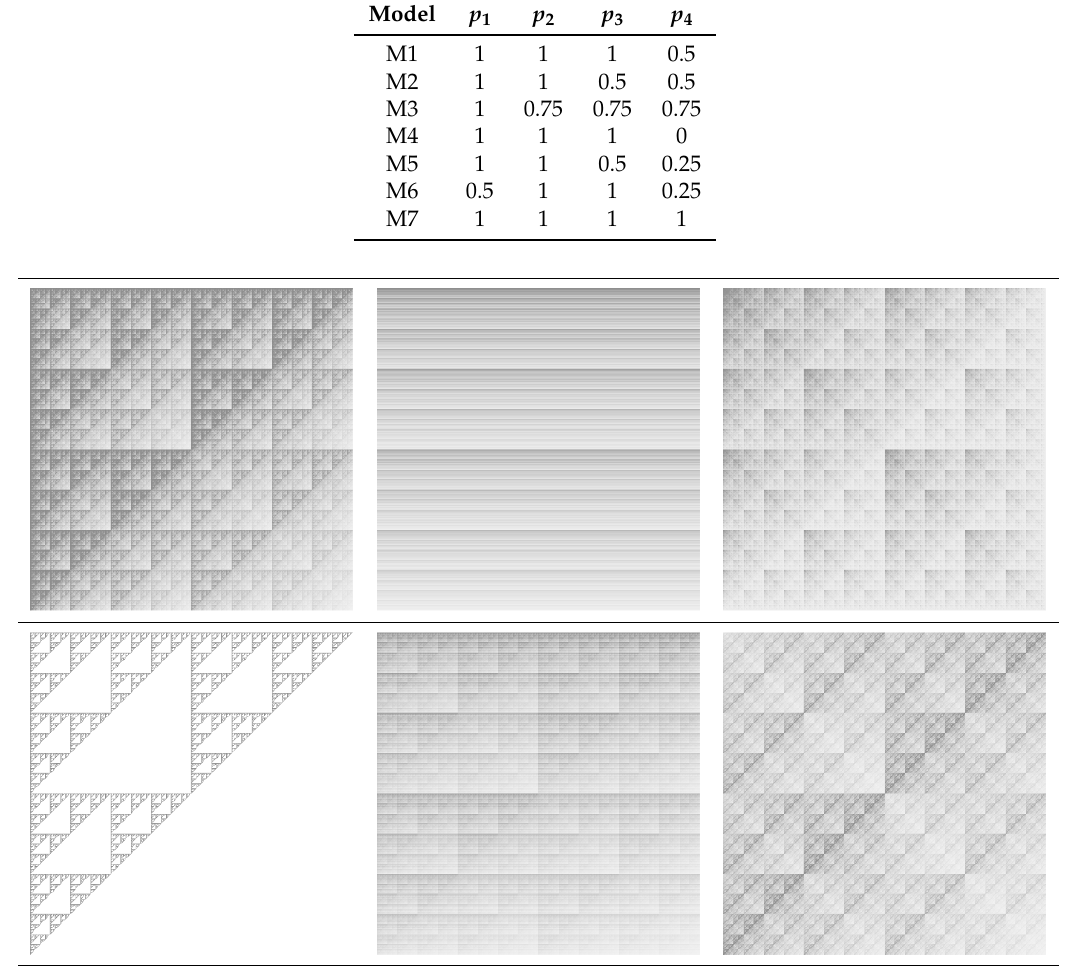
Figure 2. Six configurations M1, M2, M3, M4, M5, and M6 of the multiplicative deterministic cascade model, at iteration number n = 11. Upper part: M1, M2, M3 (from left to right). Lower part: M4, M5, M6 (from left to right). See Table 1 for the corresponding probabilities p 1 , p 2 , p 3 and p 4 . The model M7 is not shown here, since it corresponds to a uniformly filled